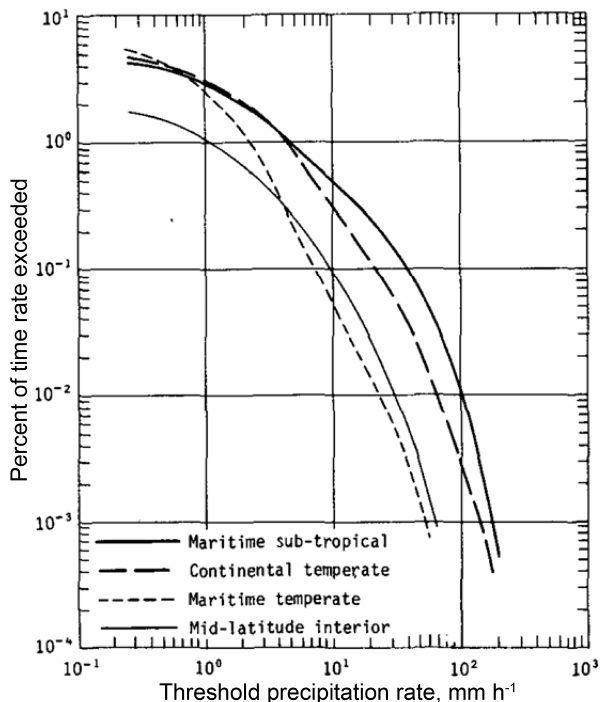
Figure 8. Average rainfall-rate–frequency relationships for four rain climates (Jones and Sims, 1978) American Meteorological So- ciety©. Used with